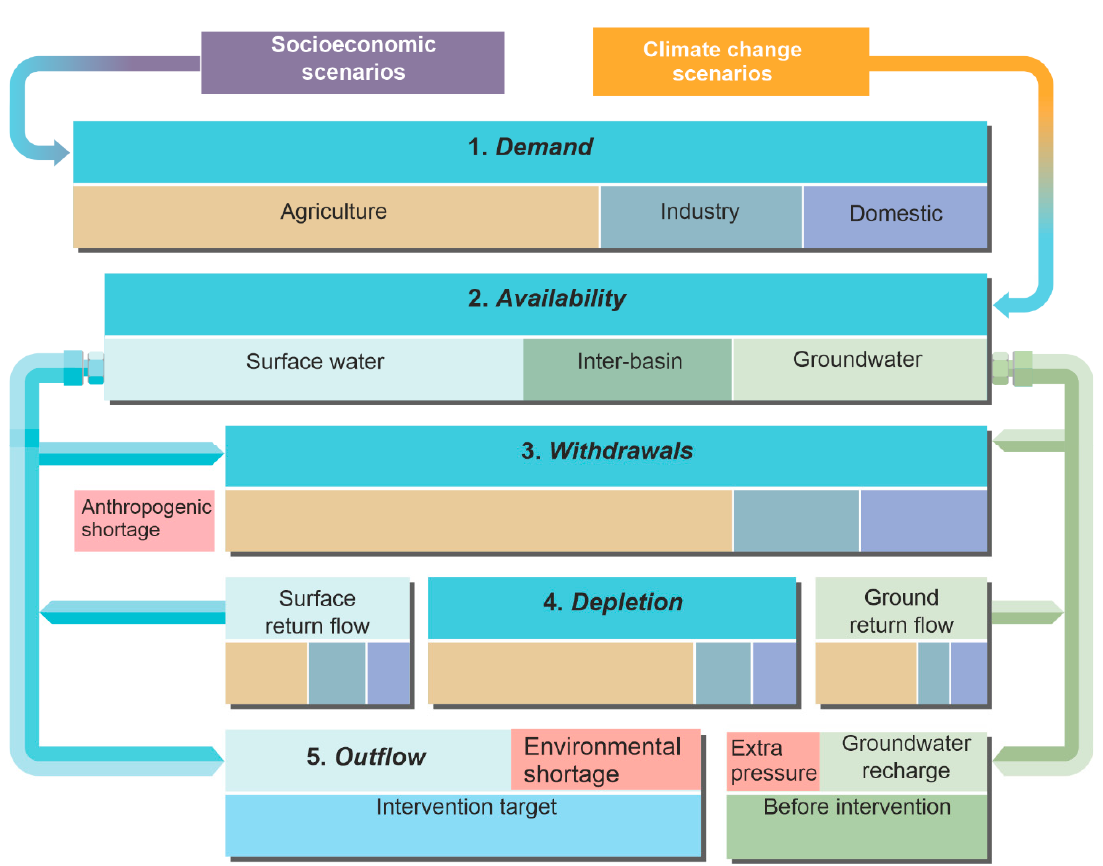
Figure 2. The water-saving strategies assessment (WSSA) framework with the five key components relating to the water balance of the entire river basin. Water-saving strategies can affect all five components directly or indirectly. Therefore, to assess the impact of water-saving strategies on the basin, the five components should be estimated ex-ante and ex-post of an intervention.